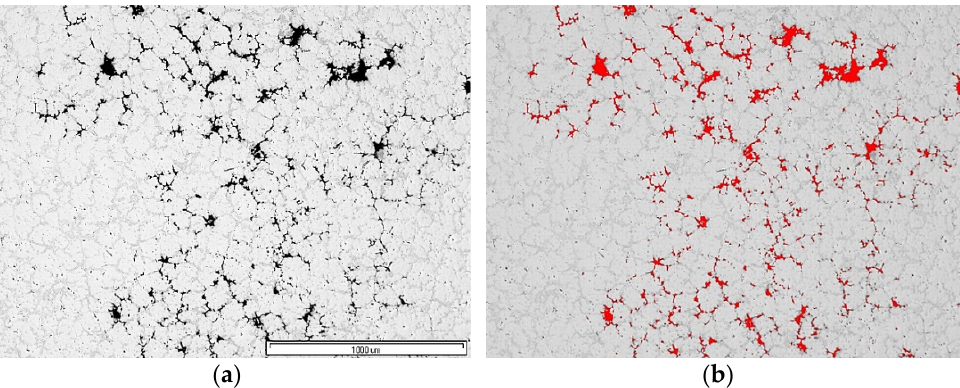
Figure 3. Porosity evaluation procedure: ( a ) gray input image; ( b ) detection, image for measure- ment.